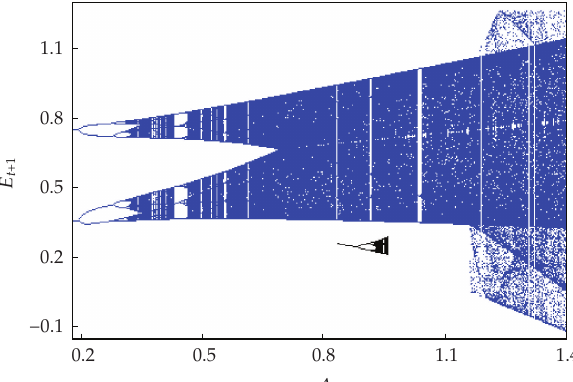
Figure 3: Overlapping bifurcation diagrams varying A .